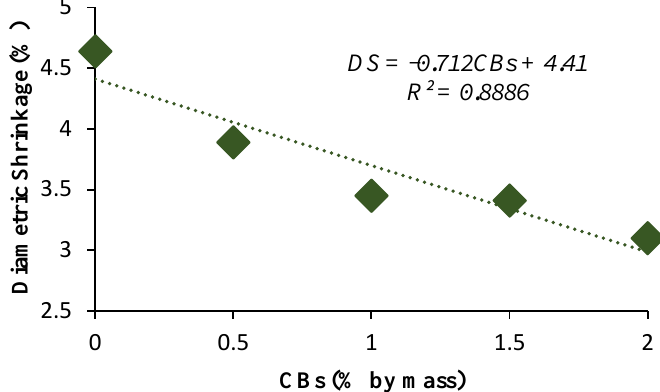
Figure 8. Diametric shrinkage versus CB percentage by mass.